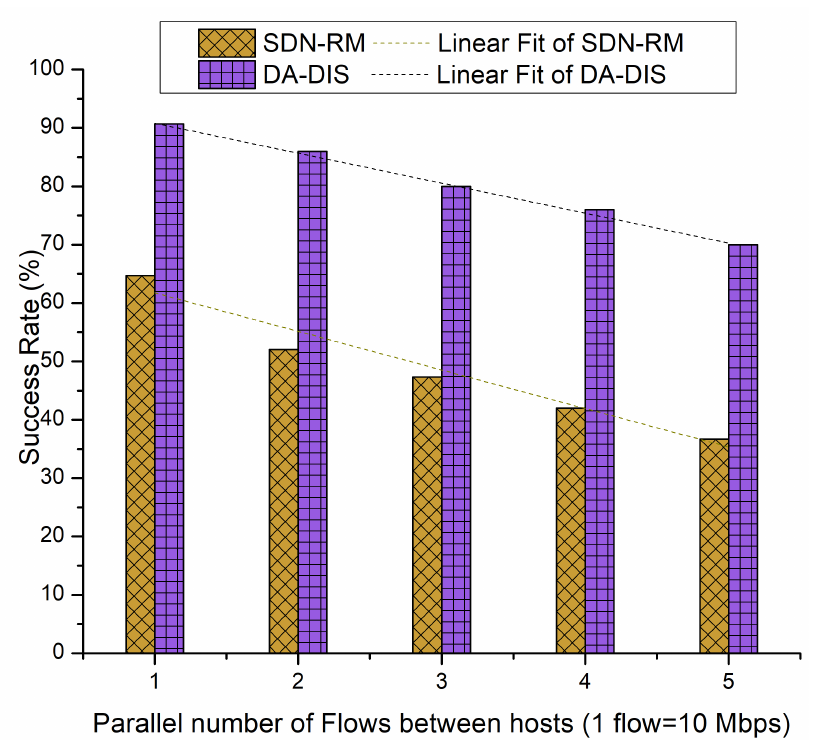
Figure 20. Success rate considering different numbers of parallel flows with one malicious switch along with E2 category